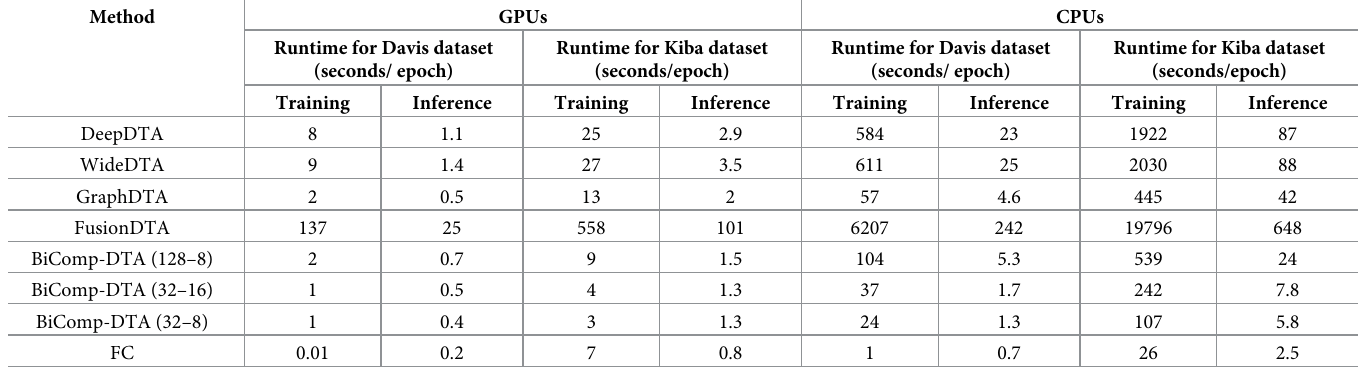
The numbers in parentheses indicate the number and the length of filters for our method, respectively.